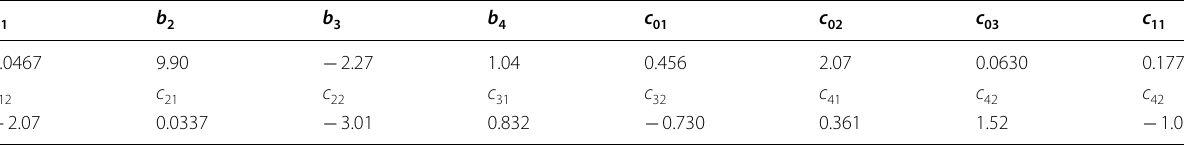
Table 2 Fitting constants of the EPLD-Ring model